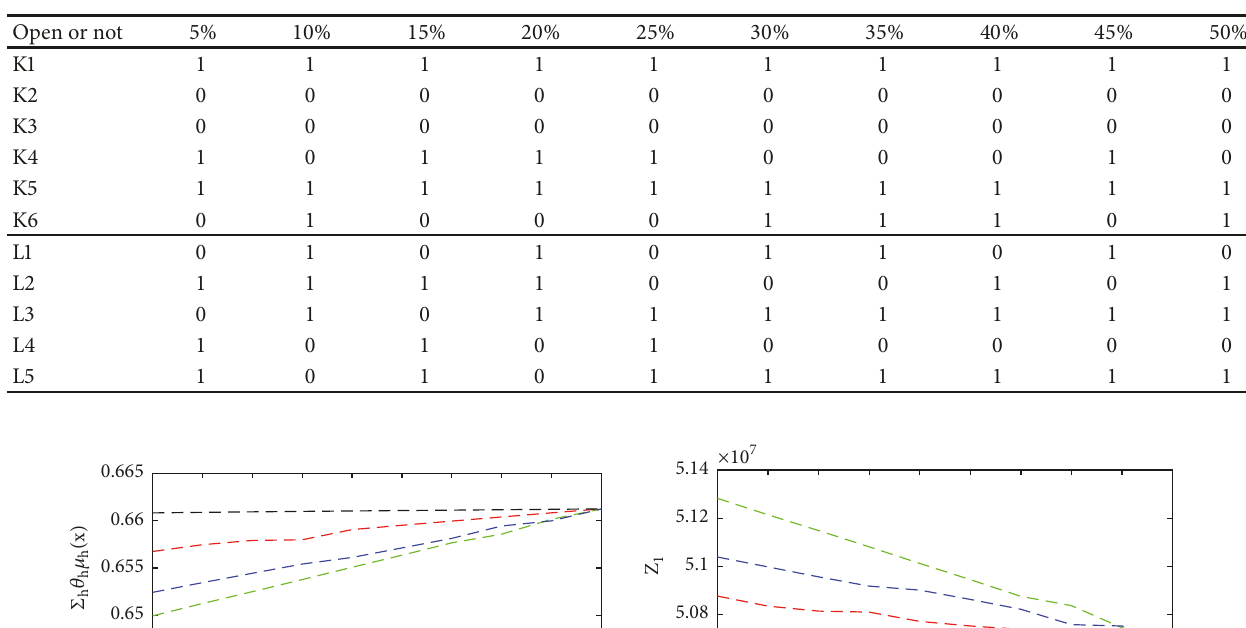
Table 19: Impact of ferrous material’ selling price on choice of opening sites.